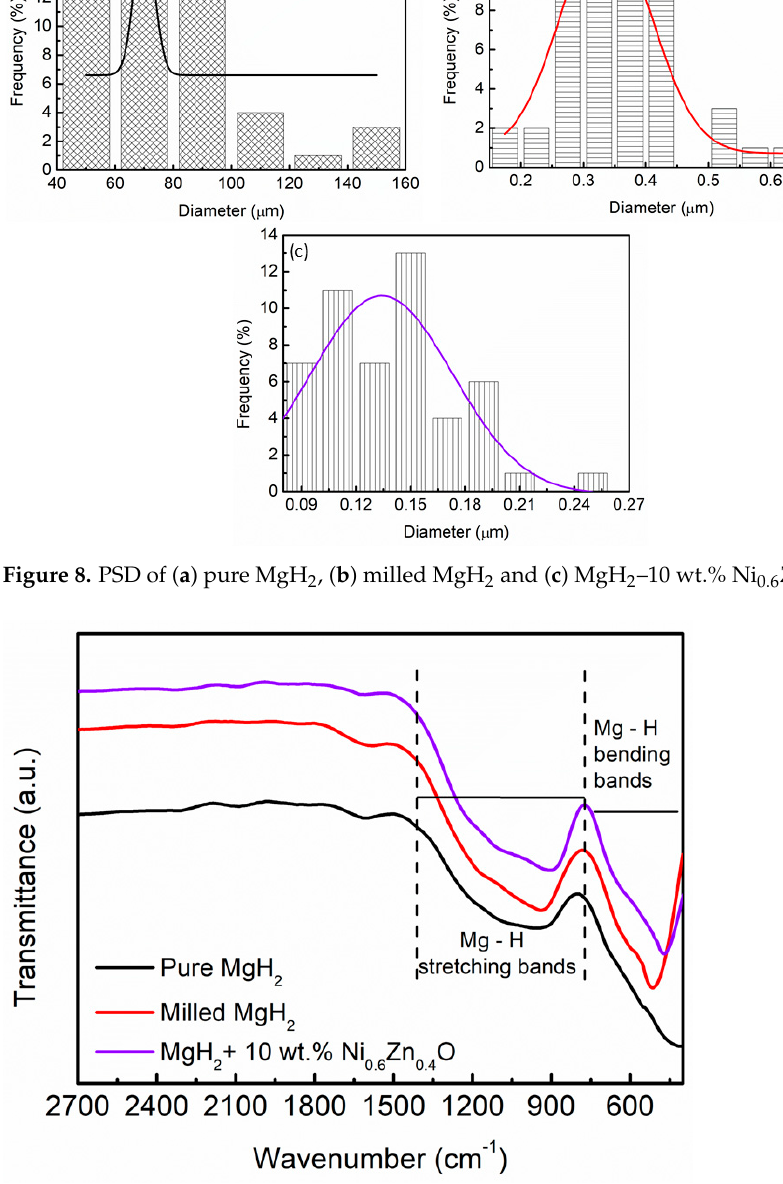
Figure 8. PSD of ( a ) pure MgH 2 , ( b ) milled MgH 2 and ( c ) MgH 2 –10 wt.% Ni 0.6 Zn 0.4 O samples.